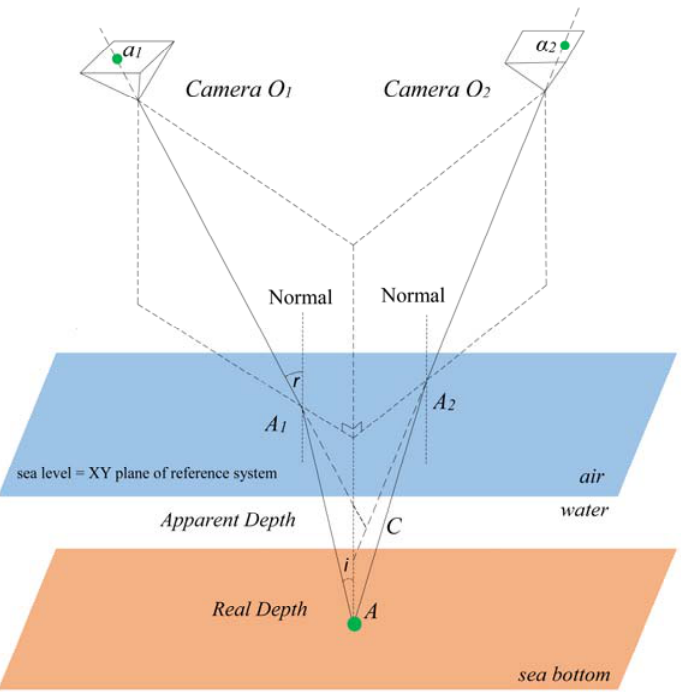
Figure 2. The geometry of two ‐ media photogrammetry in the stereo case [10].